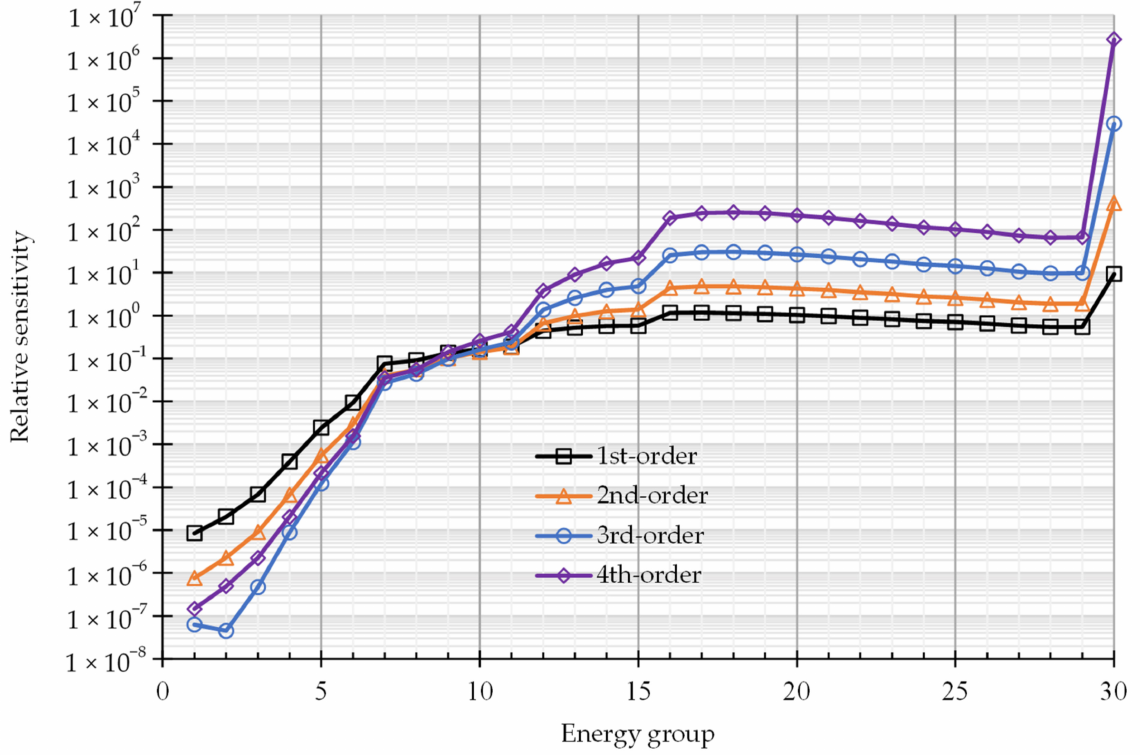
Figure 3. Illustration of the absolute values of the 1st-order through 4th-order unmixed relative sensitivities for isotope 6 ( 1 H) of the PERP